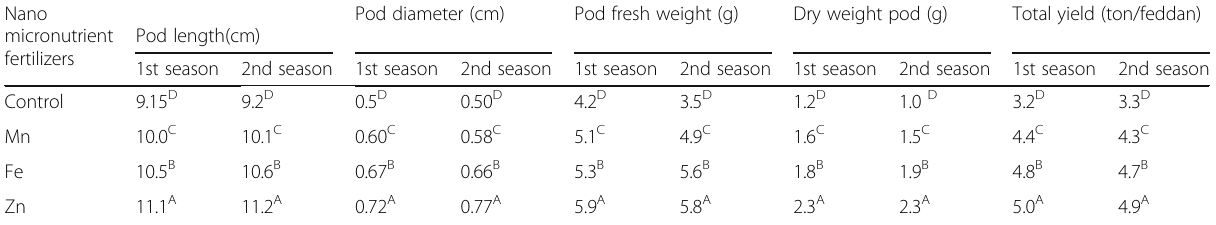
Table 6 Effect of nano micronutrient fertilizers on pod physical quality and yield of snap bean plants during 2017 and 2018 seasons Nano micronutrient